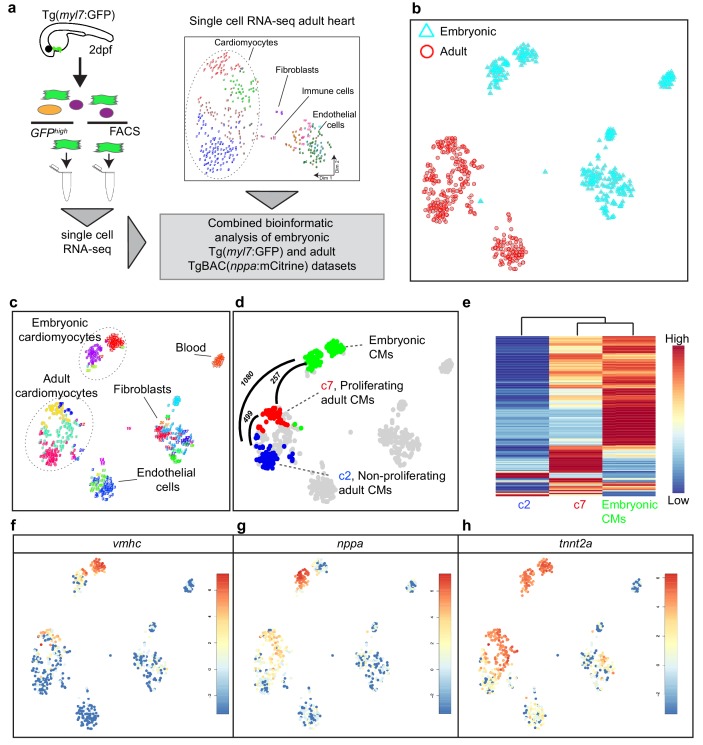
Single-cell transcriptome of border zone cardiomyocytes resembles that of embryonic cardiomyocytes.(a) Cartoon to illustrate the experimental procedure for single cell analysis of embryonic and adult cardiac cells. (b) tSNE map of combined adult (red) and embryonic datasets (light blue). (c) tSNE map indicating the different cell types based on marker gene expression. (d) tSNE map with the adult cardiomyocytes of the injured heart (cluster 7 in red, cluster 2 in blue and clusters 1 and 4 in gray) and embryonic (2 dpf) cardiomyocytes (in green), with number of pairwise differentially expressed genes (p-value<0.01) indicated between cardiomyocyte clusters. (e) Heatmap with hierarchical clustering based on the 500 most differentially expressed genes between clusters. Red color represents high expression, blue color represents low expression. Rows represent individual genes. (f–h) tSNE maps visualizing log2-transformed read-counts of vmhc (f), nppa (g) and tnnt2a (h).Figure 2—source data 1.Single-cell mRNA sequencing data from Tg(cmlc2:GFP) zebrafish hearts at 2 days post fertilization.Raw reads are represented per gene (rows) and single cell (columns).Figure 2—source data 2.List of the clusters from the embryonic heart data (SD5) identified by StemID and the associated cells for each cluster.Figure 2—source data 3.Combined single-cell mRNA sequencing data from embryonic and adult hearts.Raw reads represented per gene (rows) and single cell (columns).Figure 2—source data 4.List of pairwise differentially expressed genes between all cardiomyocyte clusters from the combined embryonic and adult datasets.Only genes with a p-value<0.01 are listed. Per gene, the log2 fold change, adjusted p-value (padj) and associated gene name are given. GO-terms for genes upregulated between clusters 5 and 6 (p<0.01) are listed in separate excel sheets.